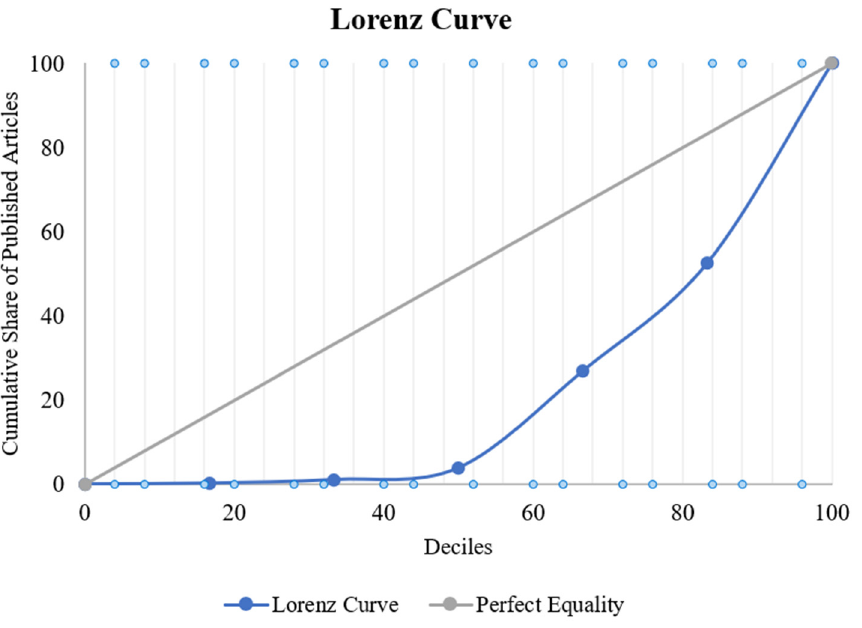
Figure 3. Lorenz Curve.